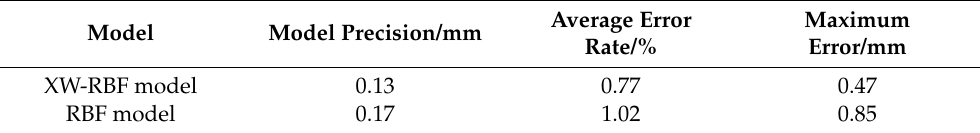
Table 2. Comparison between measured and predicted settlements of measuring points 2 − 3.